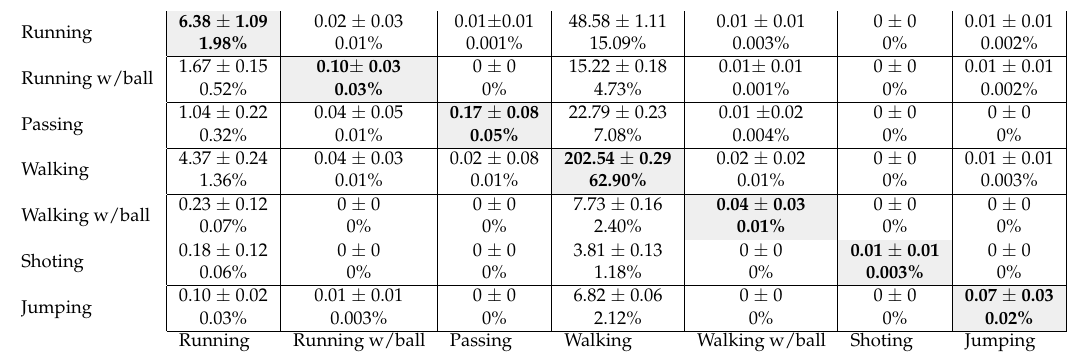
Table 5. ANN Confusion